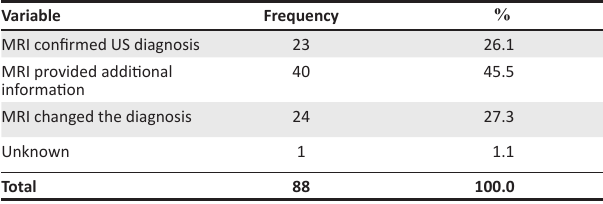
TABLE 2 : Magnetic resonance imaging contribution.